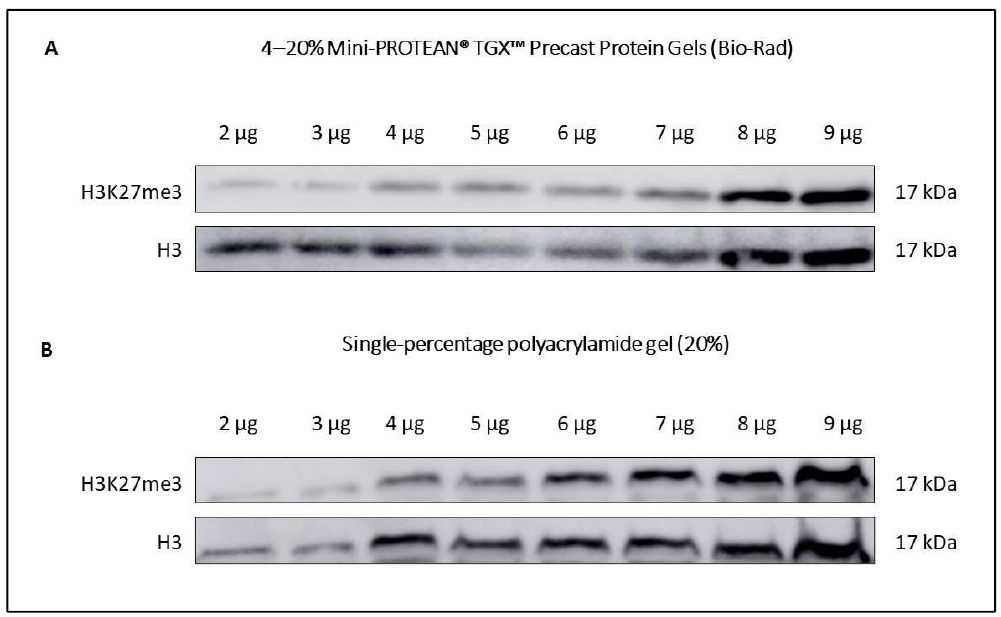
Figure 2. Analysis of different protein concentrations to study H3K27me3 in OA1 cartilage by Western blotting. The weight of the starting material was 1.20 g. ( A ) SDS-PAGE electrophoresis was performed using 4–20% Mini-PROTEAN ® TGX TM Precast Protein Gels (Bio-Rad). ( B ) SDS-PAGE electrophoresis was performed using a single-percentage polyacrylamide gel (20%). Both gels were transferred to 0.2 µm nitrocellulose membranes (Bio-Rad) to incubate them with primary antibodies against H3K27me3 (#9733, Cell Signaling Technology, 1:1000) overnight at 4 °C and H3 (#14269, Cell Signaling Technology, 1:10,000) for 5 min ( A ) and 1 h ( B ) at room temperature (RT). Secondary antibodies Rabbit IgG HRP Linked Whole Ab (NA934, 1:2000) and Mouse IgG HRP Linked Whole Ab (NA931, 1:2500) were used, respectively. Table 5. Composition and storage of Western blot